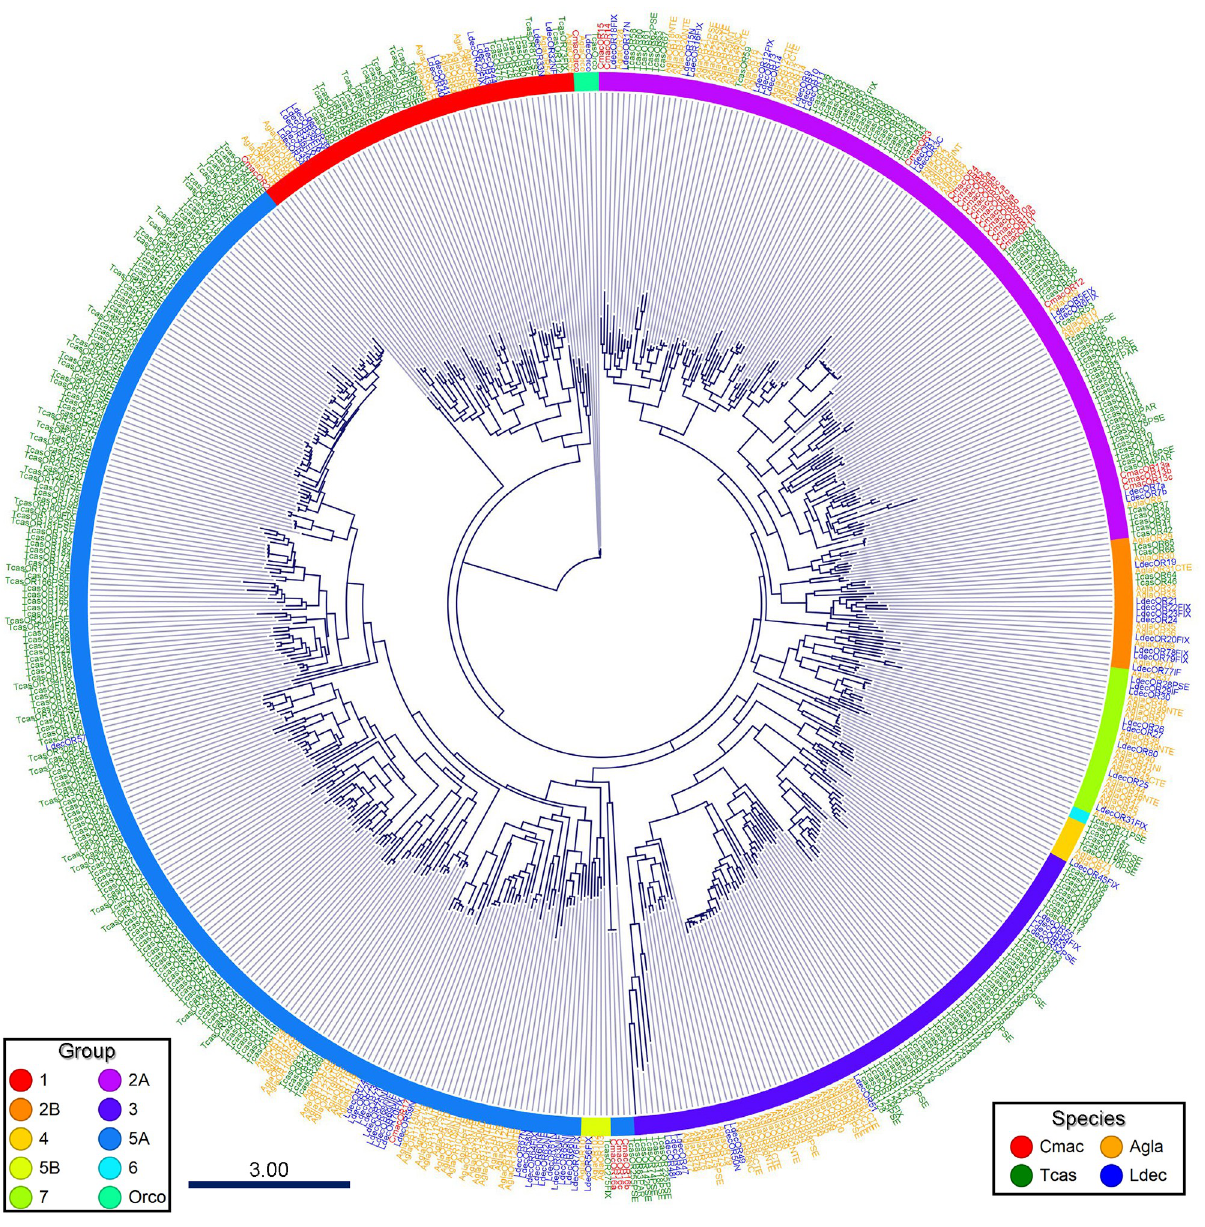
Fig 1. Maximum-likelihood phylogenetic tree of putative Callosobruchus maculatus odorant receptors (CmacORs) with insect OR sequences from Anoplophora glabripennis (Agla), Leptinotarsa decemlineata (Ldec), and Tribolium castaneum (Tcas). Thick nodes are supported by a bootstrap value > 60%. The rate of amino-acid substitutions per site is shown in the scale bar.